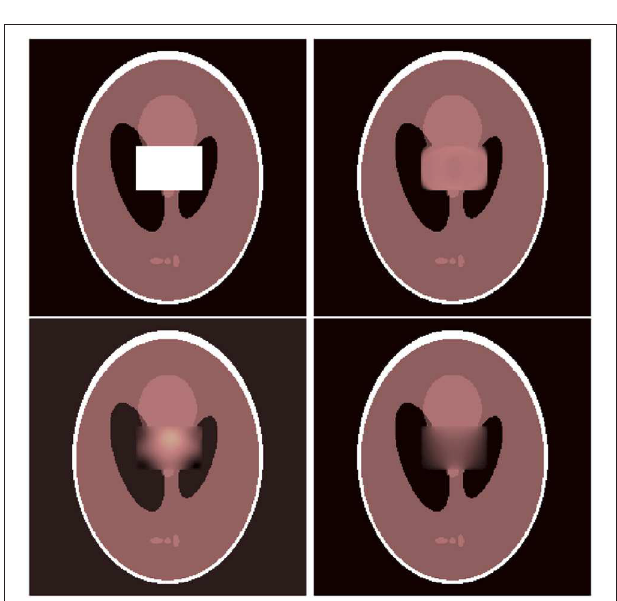
in the peppers image is missing. We use splines of order 3 for inpainting. We obtain an PSNR of 27.97 using normal TV regularization and 41.93 using the squared penalty term.